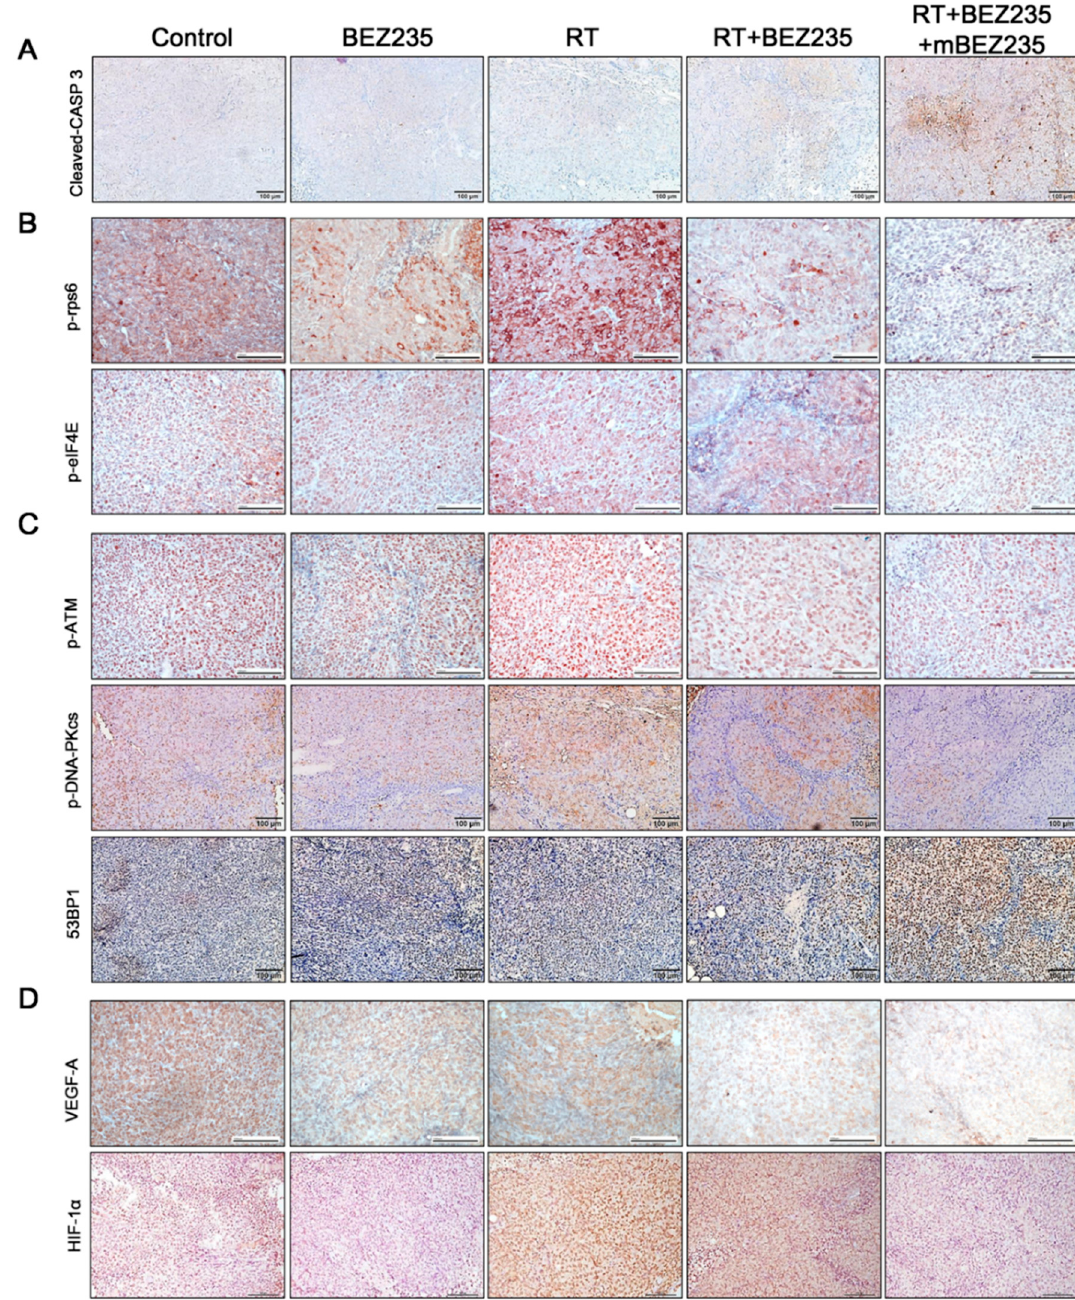
Figure 6. Expression of the apoptosis-, mTOR signaling pathway-, DNA-DSB repair-, DNA damage-, and angiogenesis-related molecules in CRC xenograft tissue following each treatment by immunohistochemistry. ( A ) BEZ235 maintenance treatment following RT + BEZ235 treatment (RT + BEZ235 + mBEZ235) significantly increased cleaved caspase-3 (CASP 3) expression when compared with other four treatments on day 43. ( B ) p-rpS6 and p-eIF4E expression after RT + BEZ235 + mBEZ235 treatment was downregulated when compared with those after RT + BEZ235 or control treatment on day 43. ( C ) RT + BEZ235 + mBEZ235 treatment significantly downregulated p-ATM and p-DNA-PKcs expression when compared with RT + BEZ235 and control treatment on day 43, whereas 53BP1 expression was significantly increased after RT + BEZ235 + mBEZ235 treatment. ( D ) RT + BEZ235 + mBEZ235 treatment significantly downregulated VEGF-A and HIF-1 α when compared with other treatments on day 43. Scale bar = 100 μ m